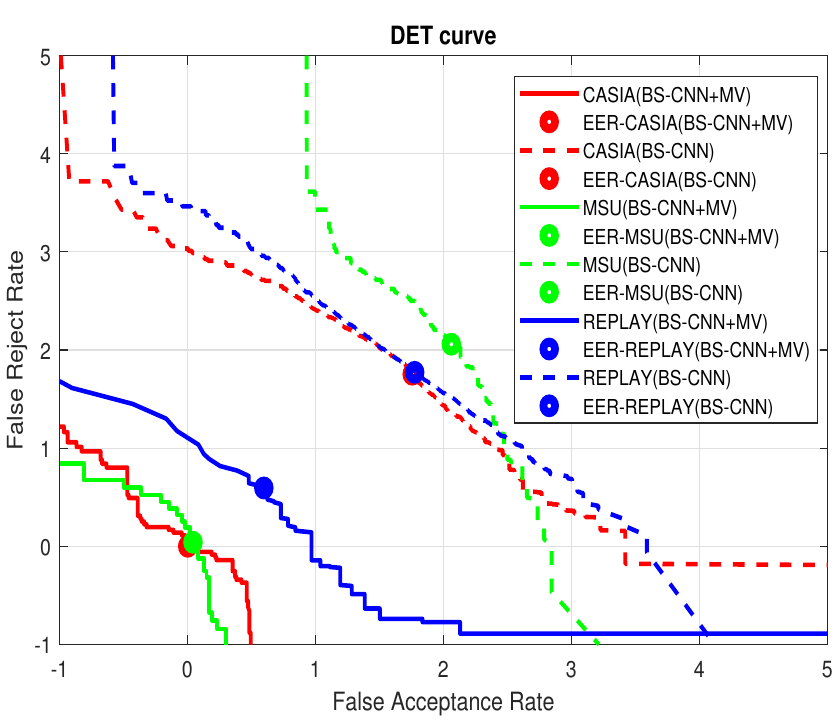
Figure 7. DET curve of the proposed approach on CASIA, MSU, and REPLAY databases.